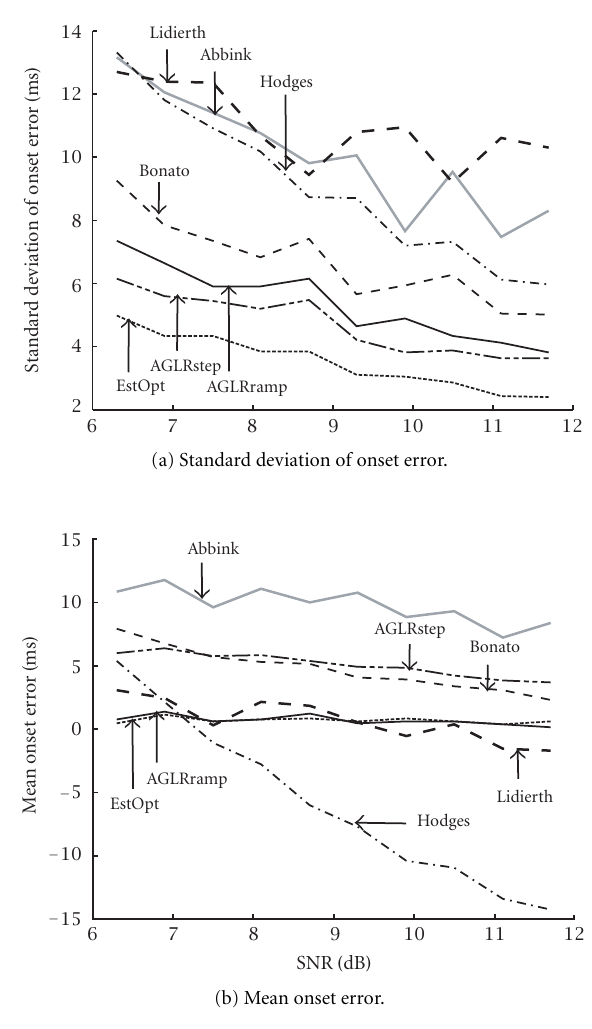
Figure 5: Dependence of onset estimation error on signal-to-noise ratio (SNR) for the Mixed SNR Trials data set (SNR 6–12dB, ramp duration